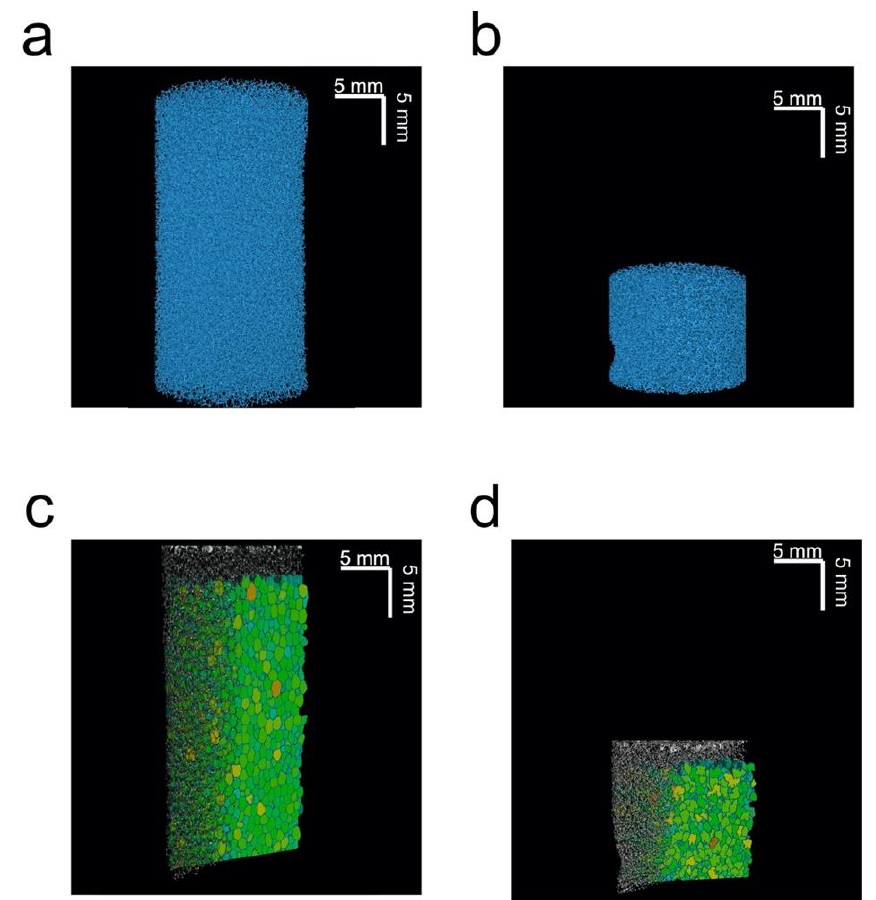
Figure 3. Three-dimensional µCT renderings of an ( a ) uncompressed and ( b ) 60% compressed plug. Three-dimensional renderings of a vertical clipping plane, with the maximum opening distribution for ( c ) uncompressed and ( d ) 60% compressed plug. All images are for the same plug. Table 1. Total number of pores and average sphericity for an uncompressed and compressed plug from X-ray µCT.